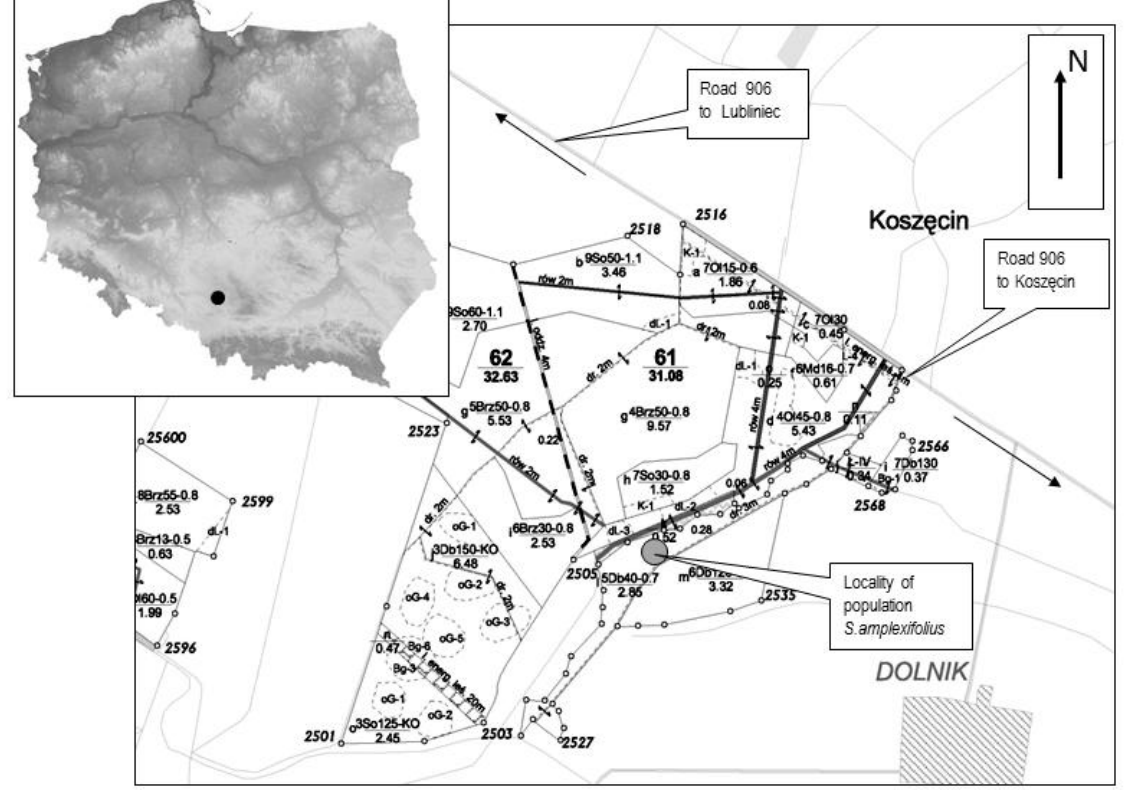
Fig. 1. Localization of the newly described population of S. amplexifolius near Koszęcin – (Silesian voivodeship, Southern Poland) against the background of forest sections